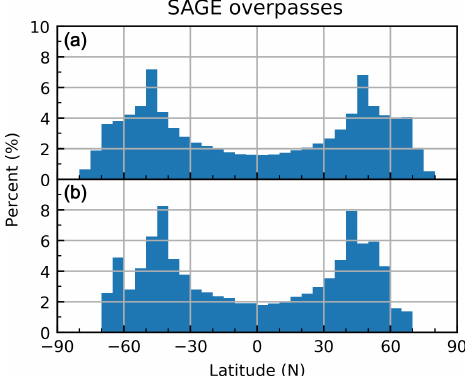
Figure 1. Zonal overpass bar charts for SAGE II (a) and SAGE III (b)